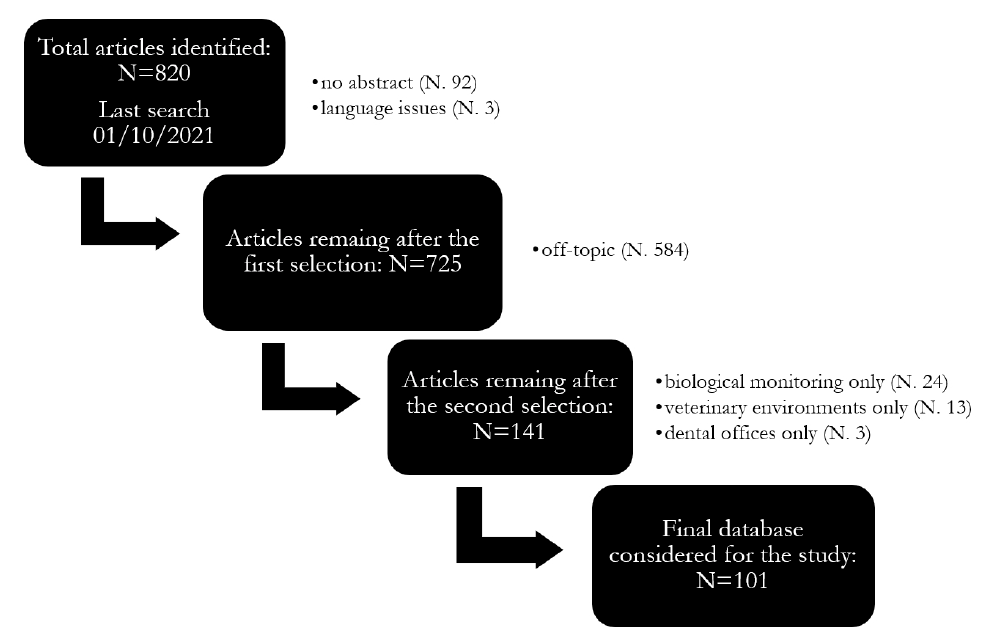
Figure 1. Flowchart of the literature research and review process adapted [39].